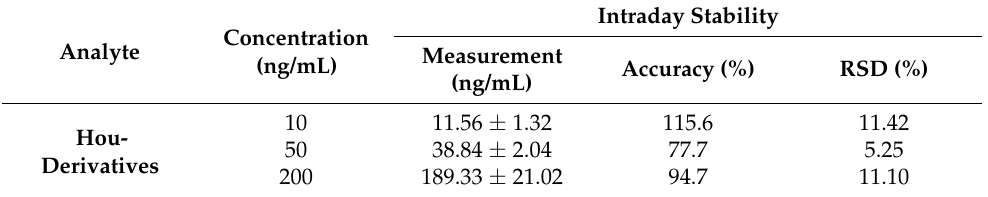
Table 3. Accuracy and precision results of Hou derivatives ( n = 6). RSD: relative standard deviation.